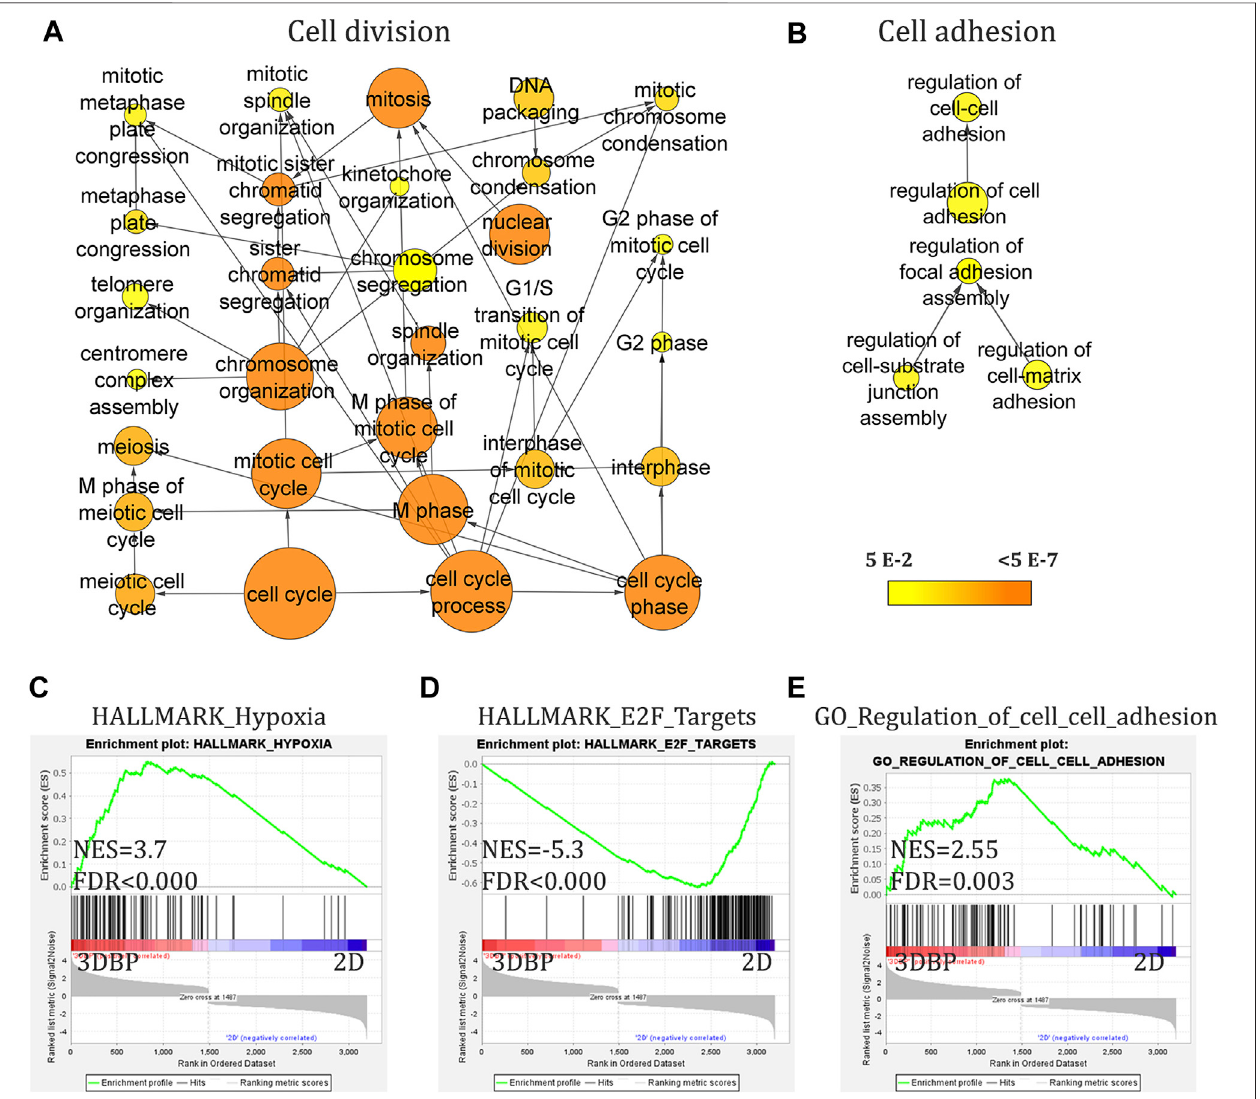
FIGURE2| RNA-seq analysisof3D bioprinted and 2D monolayer Caco-2 cells. (A) and (B) Gene ontology(GO) analysis(with BinGO inCytoscape,cutoff1.5-fold changeandadj. p -value < 0.05)ofalldifferentiallyexpressedgenesshowingnodesinvolvedincellcycleregulationandofupregulatedgenesin3Dbioprinted(3DBP)cells showing nodes for cell adhesion. (C – E) Gene set enrichment analysis (GSEA) of differentially expressed genes (cutoff 1.5-fold change and adj. p -value < 0.05) demonstrating enrichment for genes involved in hypoxia and cell – cell adhesion. ( (C) and (E) ) Negative enrichment (downregulation) of genes involved in cell cycle